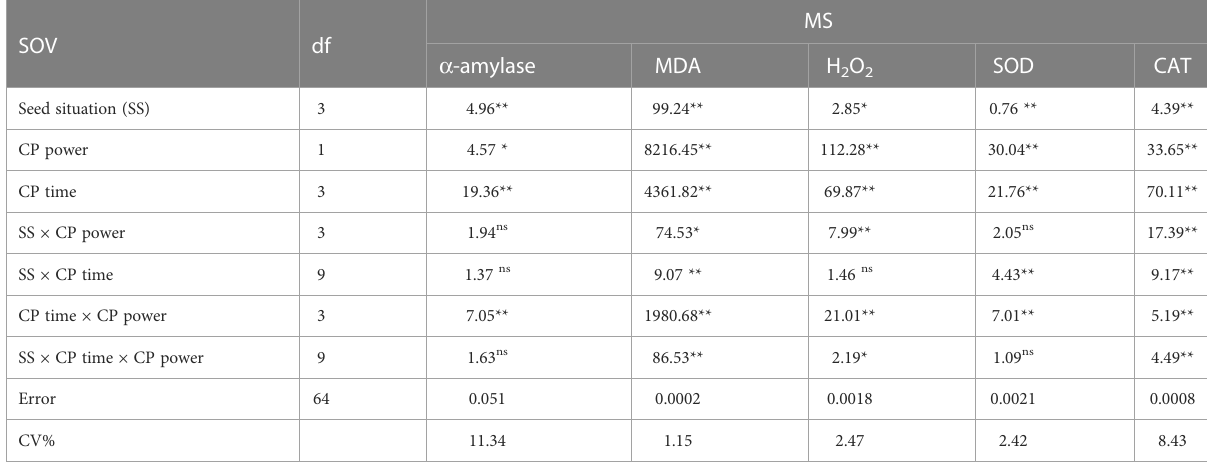
TABLE 6 Variance analysis of the effect of seed situation, cold plasma (CP) power, and exposure time of cold plasma on a -amylase, MDA, H 2 O 2 , and antioxidant enzyme activities of S. leriifolia seeds.